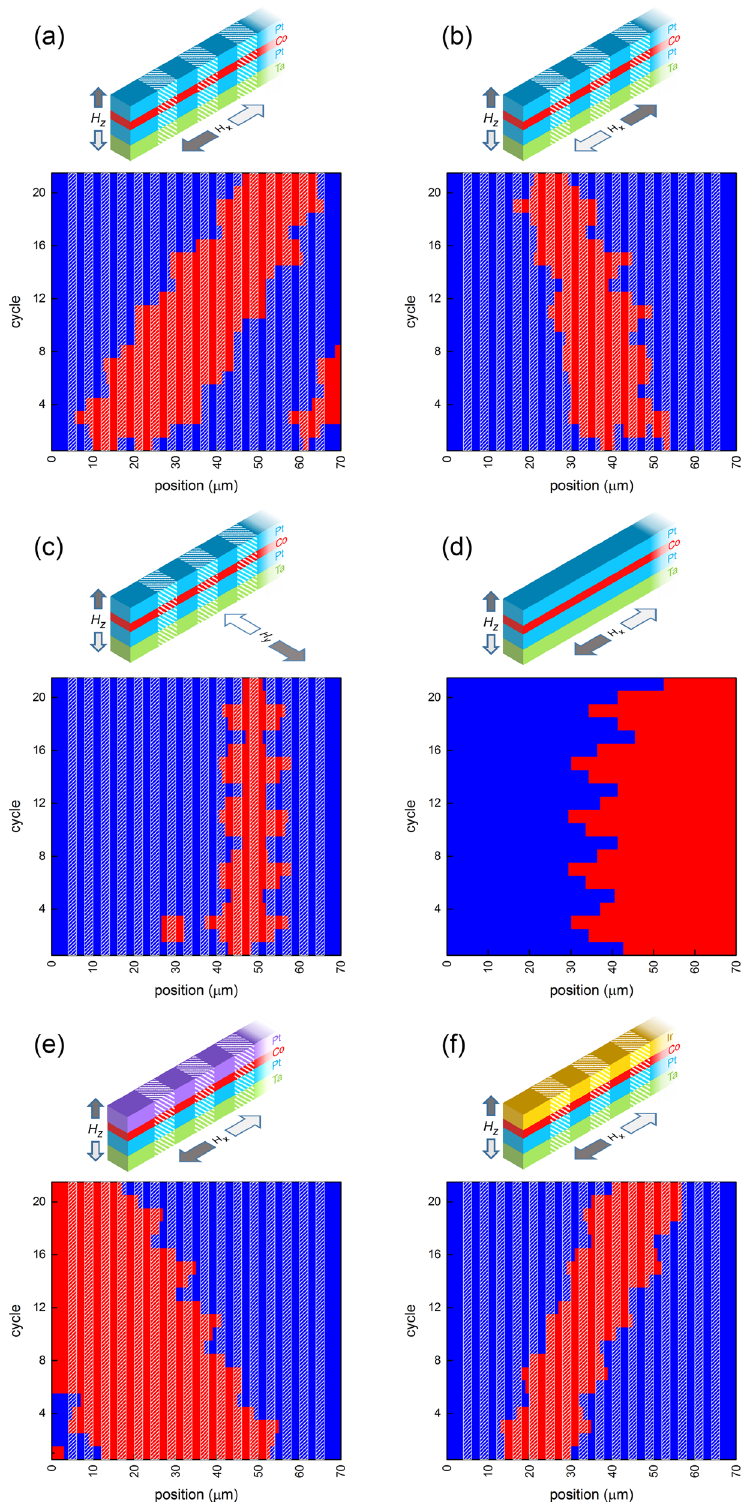
Figure 2. Magnetic configuration (red = down, blue = up) of a strip for every cycle in the propagation sequence. ( a ) Domain walls successfully being moved to the right, fields strengths H x and H z are 140 mT and 10.4 mT respectively. ( b ) Domain walls successfully being moved to the right by changing the sign of combined fields, field strengths H x and H z are 140 mT and 9.2 mT respectively). ( c ) In-plane fields (120 mT) are applied transverse to instead of along the strips, H are used. ( f ) Sample with top Pt layer replaced by Ir, field strengths H x = 160 mT and H z = 8.0 mT are